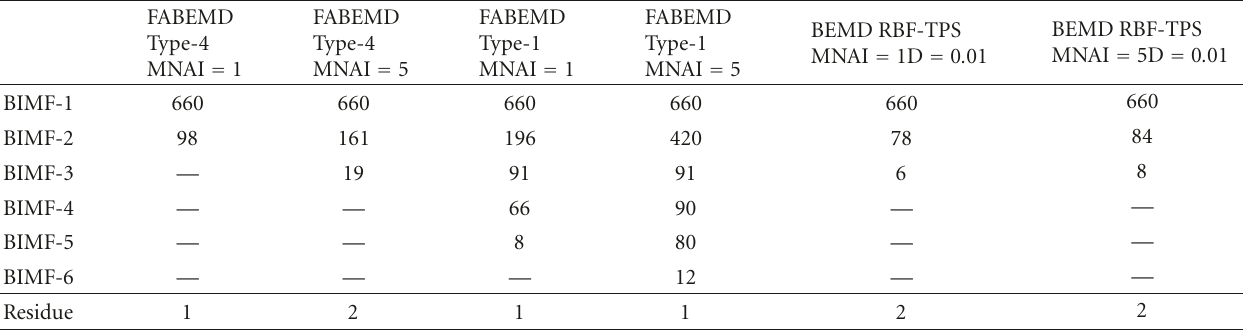
Table 5: Comparison among various FABEMD/BEMD for the STI in terms of number of extrema points in the source images for the corresponding BIMF, and the